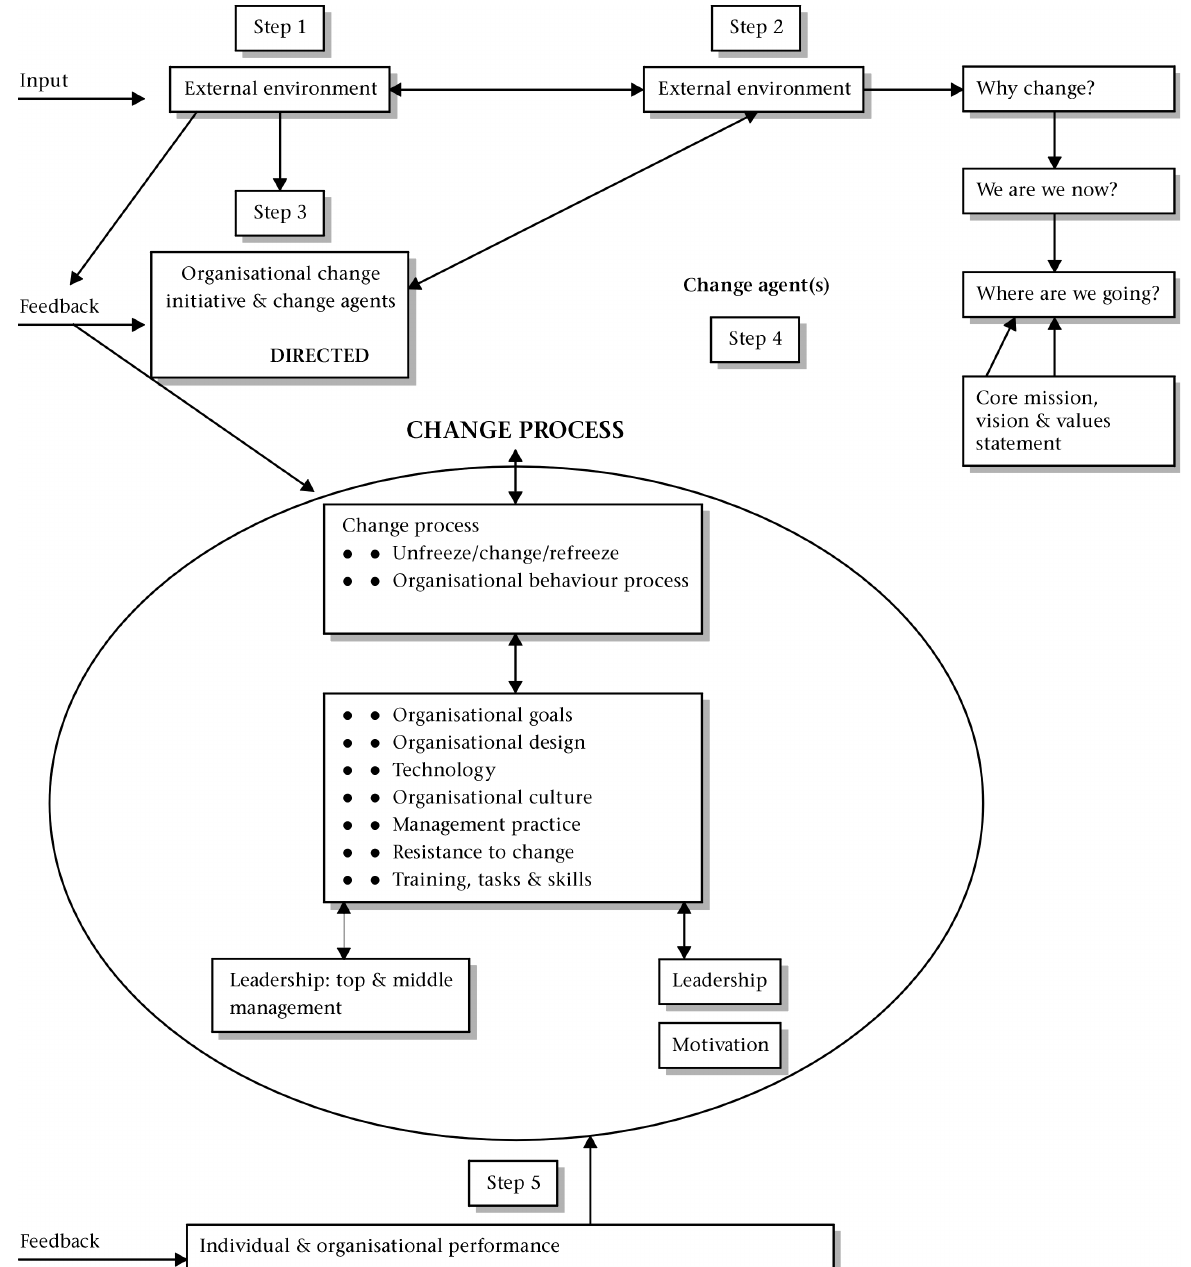
Figure 1: Determinants of